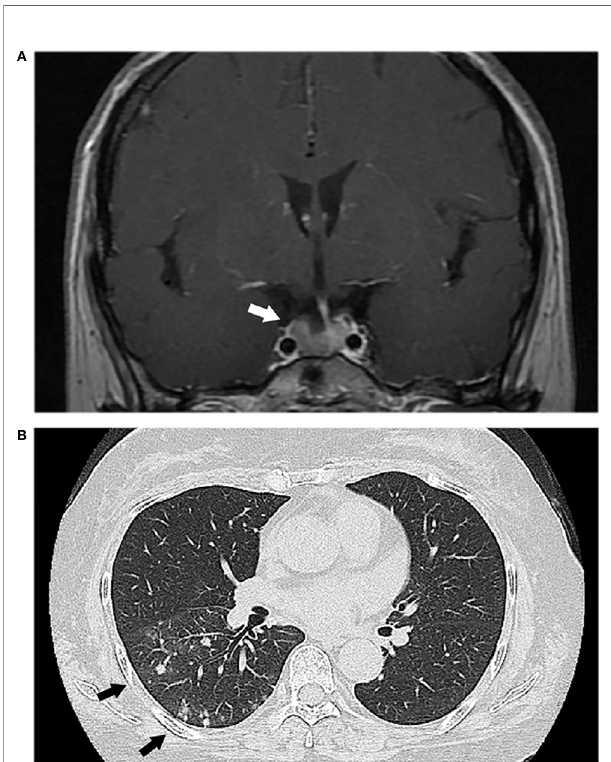
FIGURE 1 | (A) Magnetic resonance imaging showed a pituitary adenoma (white arrow). (B) Chest computed tomography revealed multiple lung nodules (black